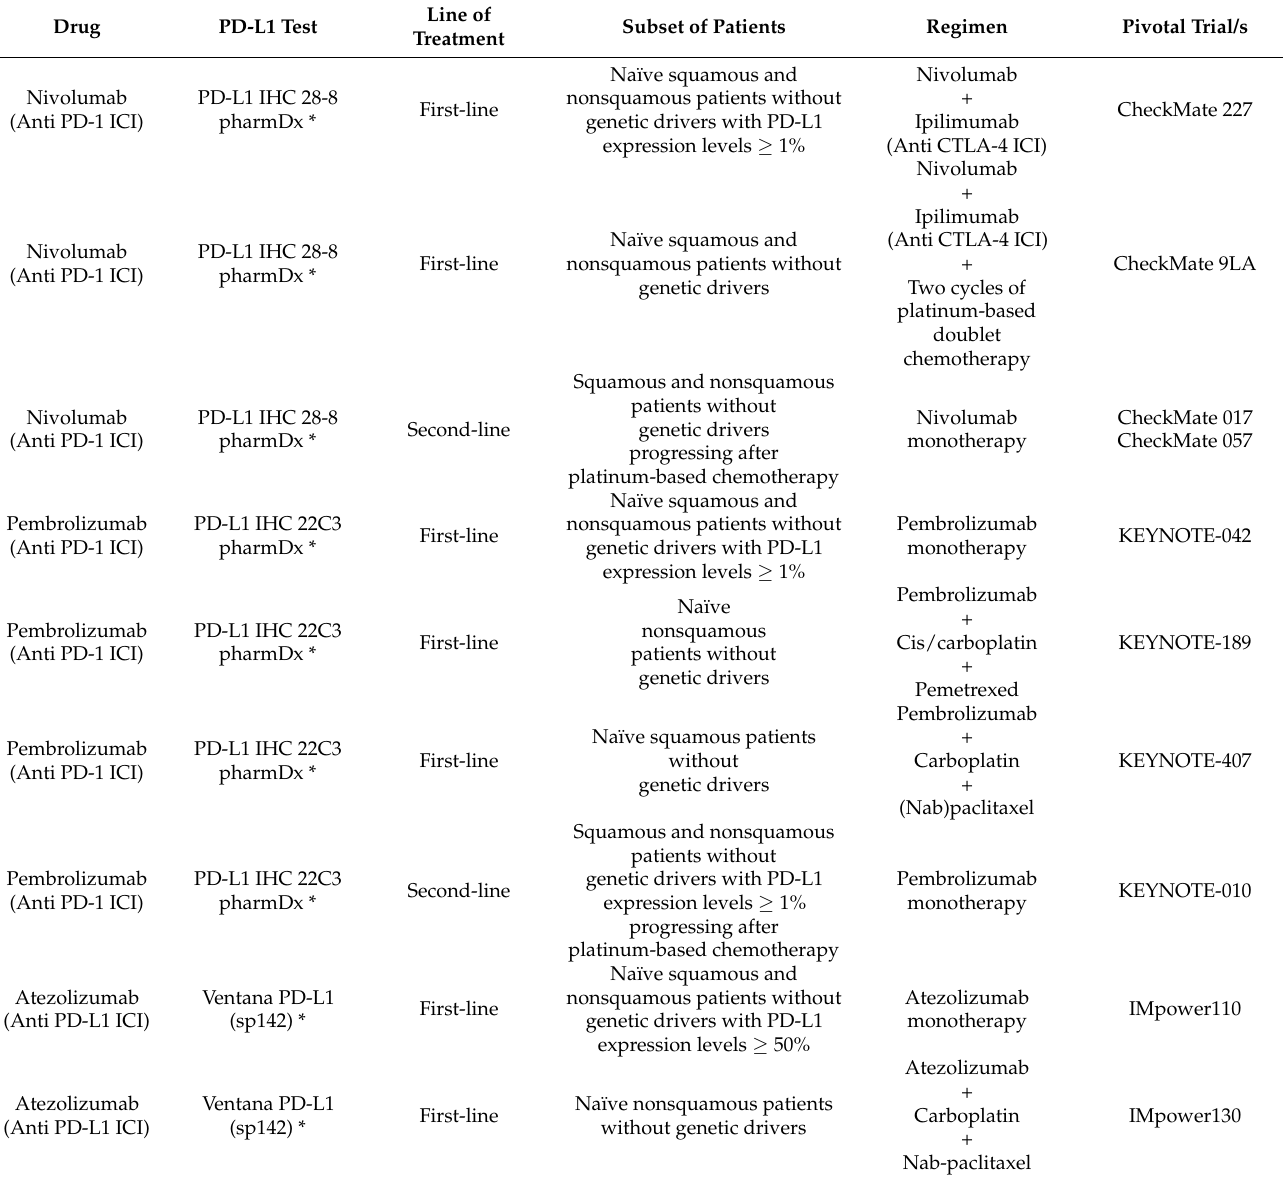
Table 1. Currently FDA-approved and international guidelines-recommended ICIs for the treatment of advanced NSCLC.